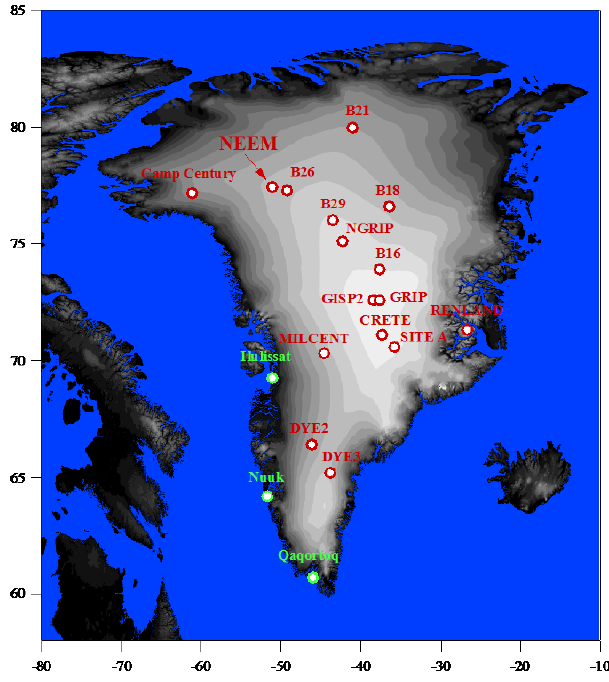
Figure 1. Map of Greenland showing the position of ice core records (red) and meteorological stations (green) used to establish a SW Greenland instrumental temperature record. The grey/white shading indicates elevation (source: NOAA/GLOBE, http://www.